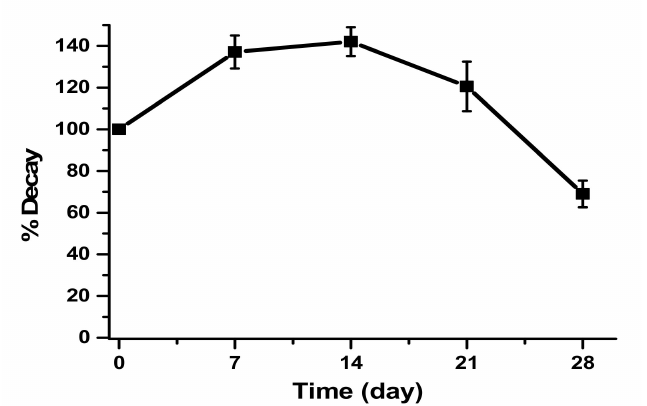
Figure 6. Storage for 28 days at 4 ◦ C of CP-50ME in the determination of catechin at 30 µ M in sodium acetate buffer pH 5.0 after 2 min and 30 s of enzymatic reaction.